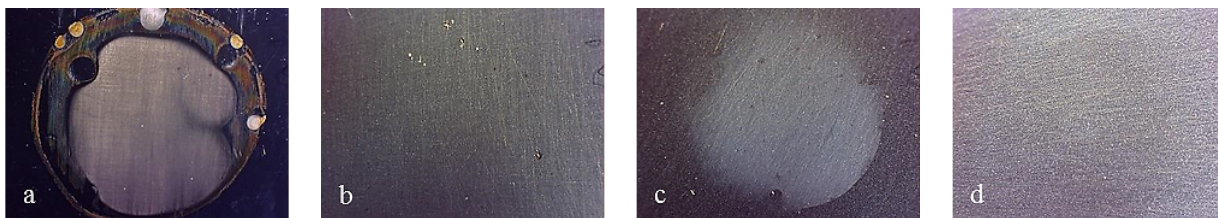
Figure 7. Working area after polarization on X2NiCoMO18-8-5 steel, mirror finished.